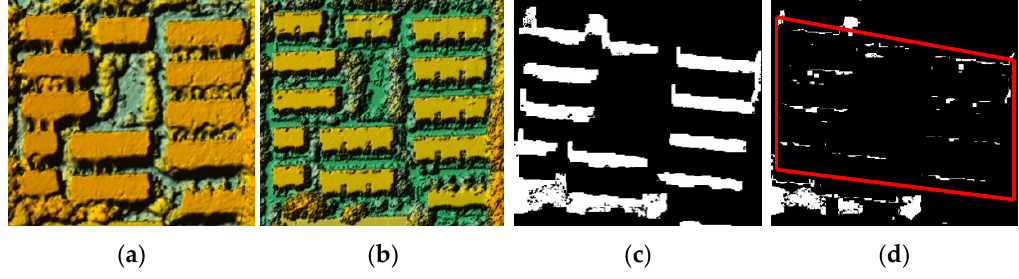
Figure 8. Example of occlusion filtering: ( a ) one region area of DSMold; ( b ) the corresponding region area of DSMnew; ( c ) initial building change detection result of this area; and ( d ) result after occlusion filtering.